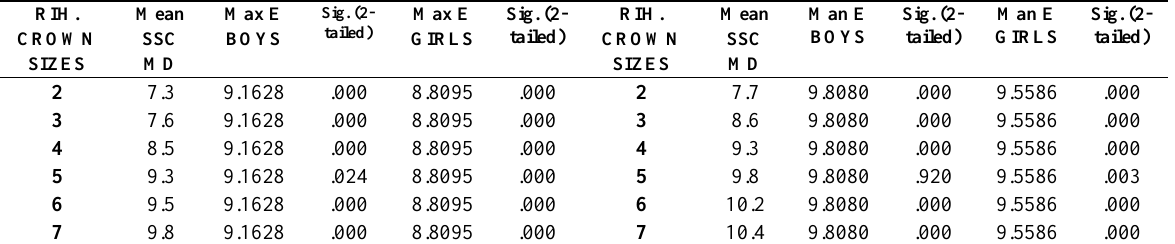
Table 5: Comparison between the MD measurements of RIHANY SSC with second primary